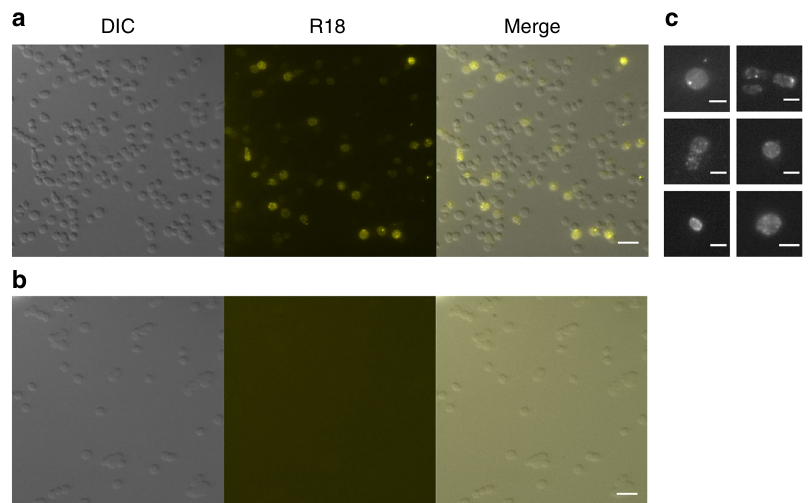
Fig. 4 Microscopy of virus-cell fusion assay. Fluorescence microscopy of the Halorubrum sp. SS7-4 cells infected with fl uorescently labelled HRPV-6 ( a ) or fl uorescently labelled spikeless HRPV-6 particles ( b ). c A close-up of cells infected with HRPV-6 showing spreading of fl uorescence evenly along the cell and viral particles fl uorescing brightly. Pictures are representatives from at least three separate experiments all of which contained both treatments. Scale bar 5 μ m ( a , b ) and 2 μ m ( c ). DIC, cells imaged using differential interference contrasting; R18, cells imaged using fl uorescence for rhodamine label; merge, an overlay of the two channels used. Source data are provided as a Source Data fi le